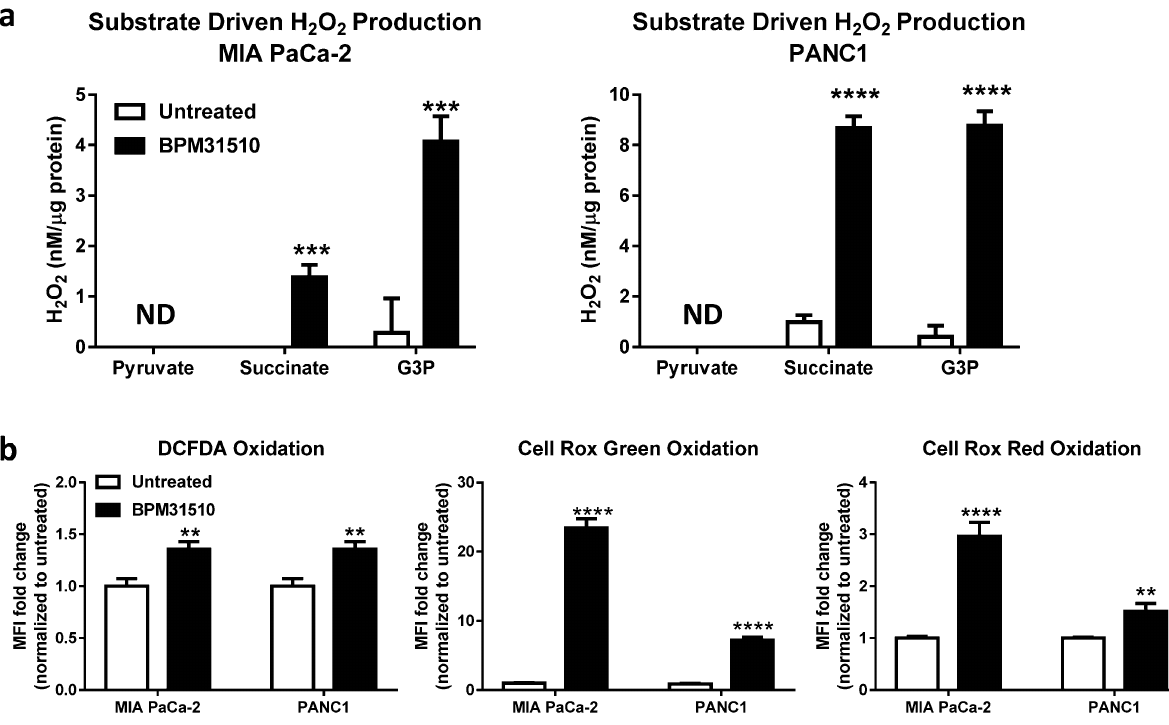
Figure 3. BPM31510 induces oxidative stress via generation of mitochondrial reactive oxygen species (ROS) in MIA PaCa-2 and PANC1 cells. ( a ) Mitochondrial H 2 O 2 generation during complex I, complex II and GPDH-driven respiration in cells were after treatment with BPM31510 (EC 50 ) for 24 h. The data represent the means + SEM of three independent experiments. The data were analysed by Student’s t test; *** p < 0.001 and **** p < 0.0001 compared to untreated. UD = undetected ( b ) Oxidation of multiple redox probes, indicative of oxidative stress, in MIA PaCa-2 and PANC1 cells after treatment with BPM31510 (EC 50 ) for 24 h. The data represent the means + SEM of three independent experiments and report the fold change in mean fluorescence intensity (MFI) normalized to untreated controls. The data were analysed by Student’s t test; ** p < 0.01 and **** p < 0.0001 compared to the untreated